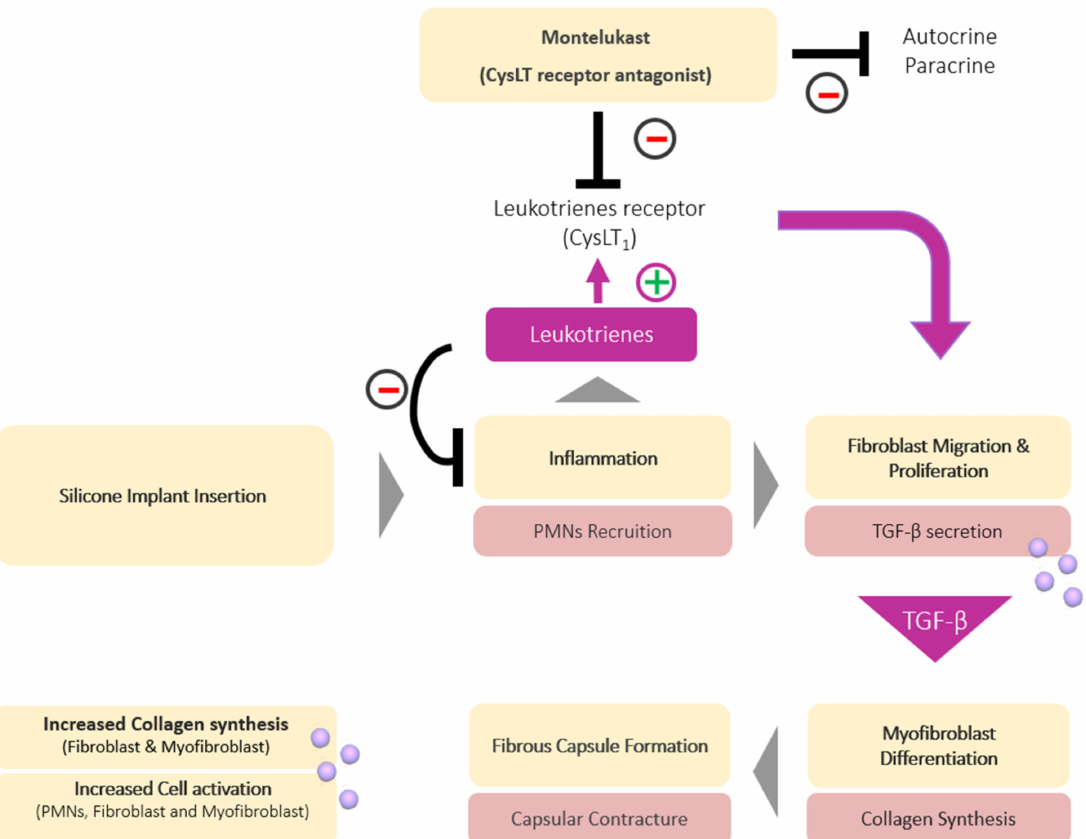
Figure 5. A representation of mechanism through which montelukast reduces the capsule contracture related to silicone breast implant. It acts as a CysLTs inhibitor which reduces chronic inflammation subsequently decreasing the fibrous capsule